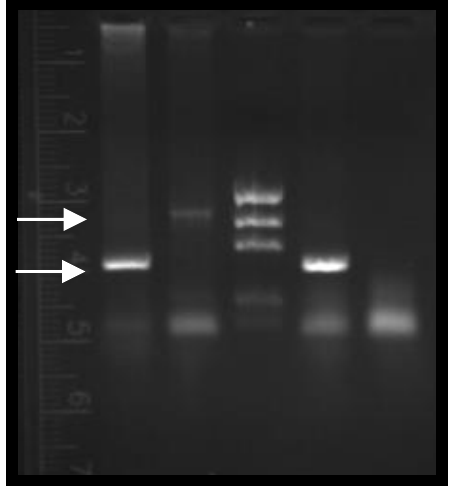
Figure 1. Genotyping of mice by PCR. (1) and (4) TgAPP mice (470 bp amplicon for the APP gen); (2) Wild-type (WT) mice (760 bp amplicon for the PrP gen); (3) MassRuler DNA ladder #170-8207;